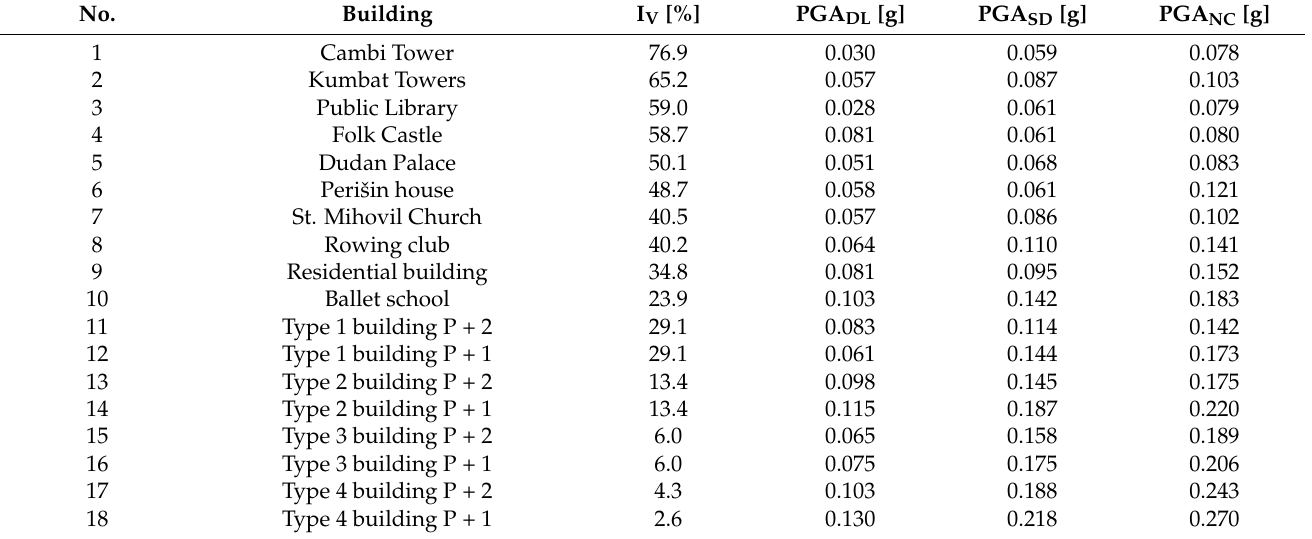
Table 2. Vulnerability index and critical peak ground accelerations of the buildings.